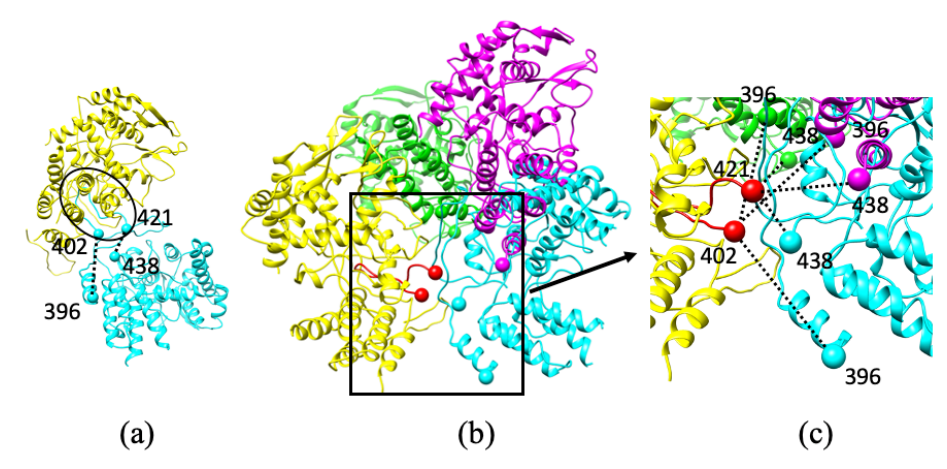
Figure 2. NP dimer arrangements . ( a ) Two interacting NP molecules from the trimer conformation (Protein Data Bank (PDB) accession code: 2IQH) are shown with the folded domain (residues 402-421) from one nucleoprotein (NP) (cyan) occupying the binding pocket of the second NP (yellow). Dotted lines between the folded domain and the main NP body are shown as a guide to the eye. ( b ) All three NP dimer arrangements are shown: trimer (cyan), circular (magenta), and helical (green) from PDB accession codes 2IQH, 2WFS, and 4BBL, respectively. The receiving NP (yellow), where the folded domain enters the binding pocket are superimposable in all three arrangements (red). ( c ) An enlarged view of the folded domain and the orientations of the trimer (cyan), circular (magenta), and helical (green) NPs shows the expected